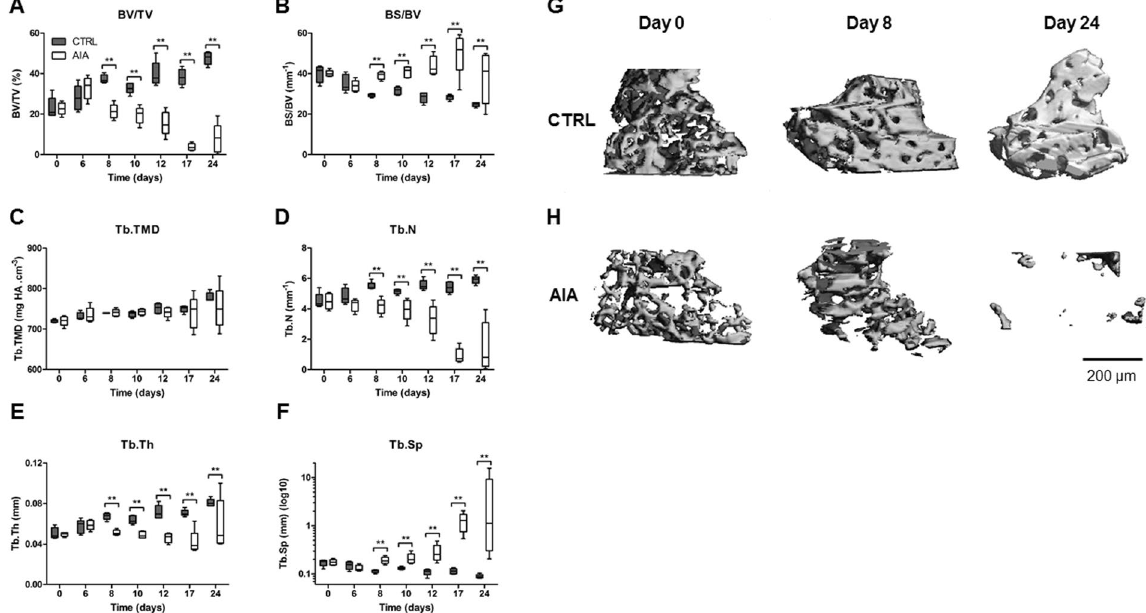
Figure 2. Trabecular changes of navicular bone in the rat AIA model compared to control. Microcomputed tomography study of the trabecular network with ( A ) BV/TV, ( B ) BS/BV, ( C ) Tb.TMD, ( D ) Tb.N, ( E ) Tb.Th, and ( F ) Tb.Sp represented at the same time points. 3-D imaging illustrating trabecular changes in CTRL ( G ) versus AIA ( H ) rats groups at day 0, 8 and 24. Scale bar: 200 µ m. AIA: adjuvant-induced arthritis (n = 5 at each time point); CTRL: control (n = 5 at each time point); BV/TV: bone volume /tissue volume; BS/BV: bone surface/bone volume; Tb.TMD: trabecular tissue mineral density; Tb.N: trabecular number; Tb.Th: trabecular thickness; Tb.Sp: trabecular separation. Boxes and bars were median ± interquartile range. Mann-Whitney test: ** p <